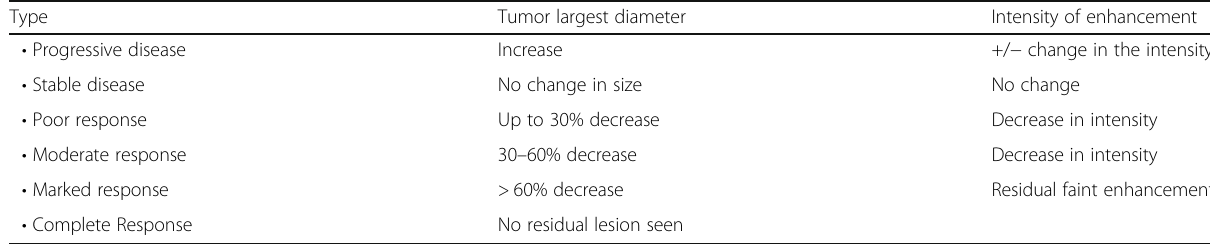
Table 1 The combined evaluation response approach